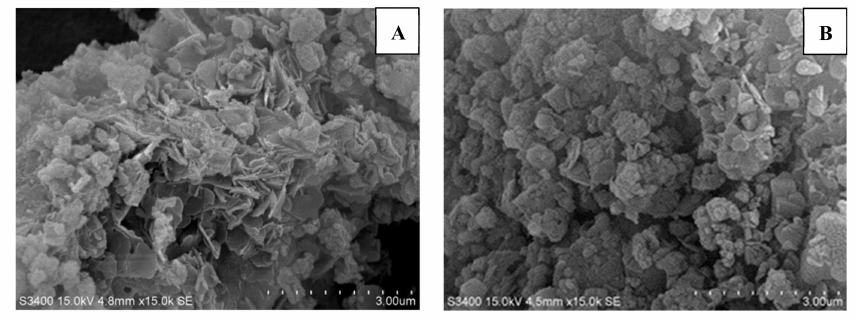
Figure 5. SEM images of pure hydrotalcites ( A ) and IL-CaMgAl ( B